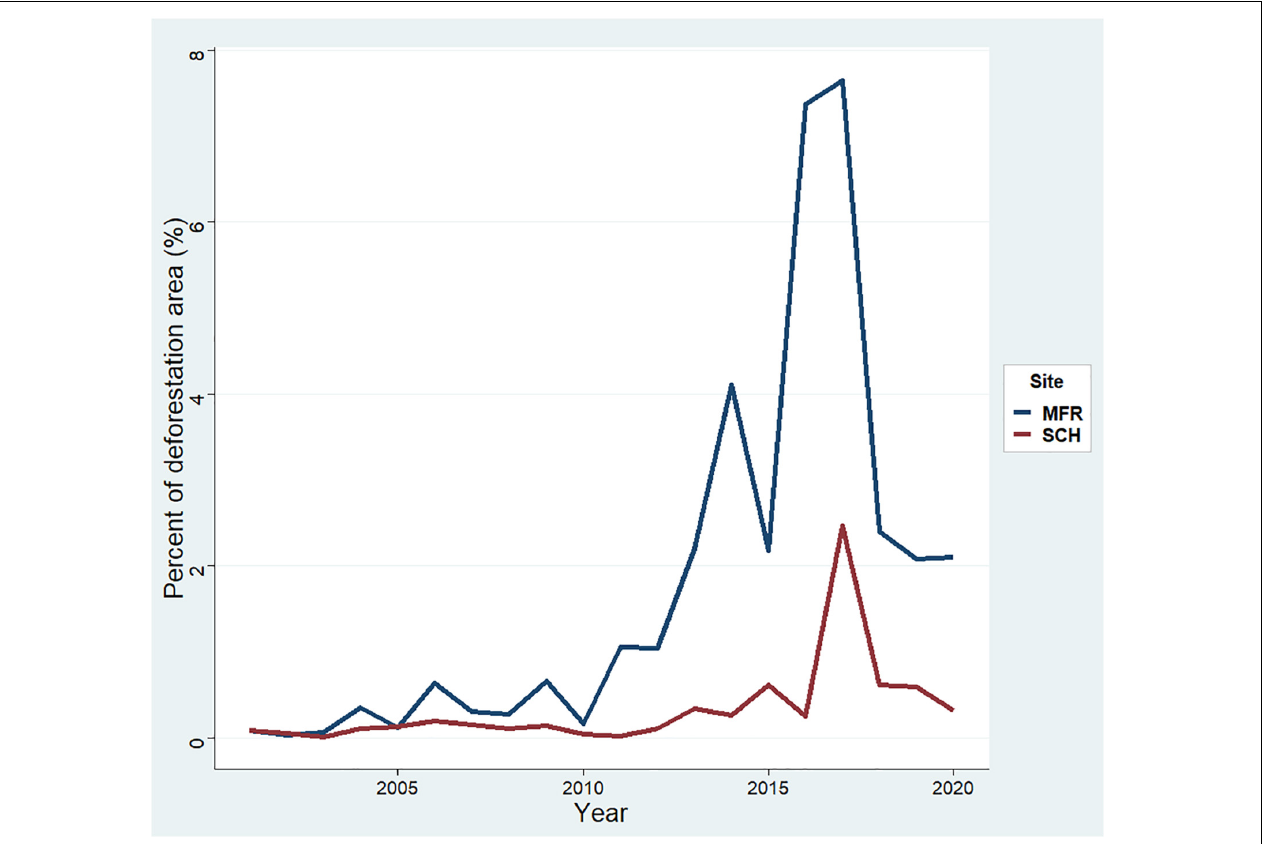
FIGURE 2 | Deforestation percentage per year in MFR and SCH (based on Hansen et al., 2013, available at: https://earthenginepartners.appspot.com/science- 2013-global-forest).